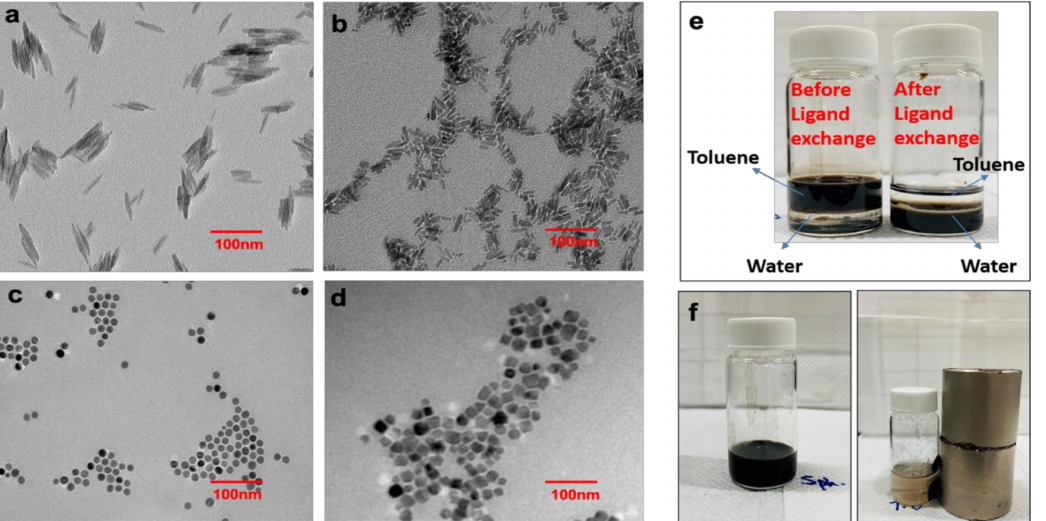
Figure 1. TEM images of iron oxide nanoparticles displaying monodispersed and diverse mor- phologies. ( a ) FeOOH nanorod precursors after hydrolysis of FeCl 3 ; ( b ) Fe 3 O 4 nanorods after reduction of FeOOH using branched PEI (B-PEI) and tetraethylene glycol (TEG) at 230 ◦ C; ( c ) Fe 3 O 4 nanospheres formed via thermal decomposition of metal-oleate precursors at 320 ◦ C; ( d ) Fe 3 O 4 truncated octahedrons formed via thermal decomposition reaction of Fe(acac) 3 , oleic acid, and trioctylamine (Scale bar: 100 nm); ( e ) the properties of nanoparticles before and after the surface func- tionalization using B-PEI 10K via a ligand exchange method; and ( f ) demonstration of the magnetic nature of the Fe 3 O 4 nanoparticles using a strong static